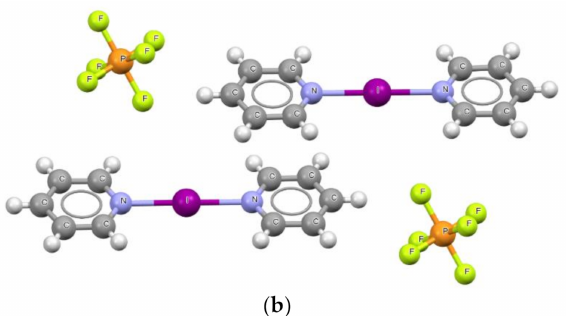
Figure 4. The fragment of the crystal structure of bis(pyridine)-silver(i) nitrate monohydrate, AGPYNO02 refcode ( a ) and di(pyridin-1-yl)iodonium hexafluorophosphate, CICQIQ03 refcode ( b ), reference [53].